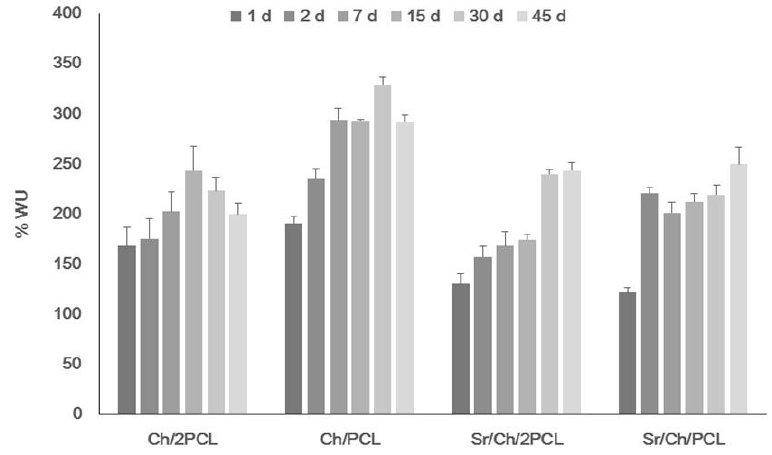
Figure 4. Variation of water uptake of membranes after immersion in PBS buffer at 37 °C. Ch: chitosan; PCL: poly( ε -caprolactone).